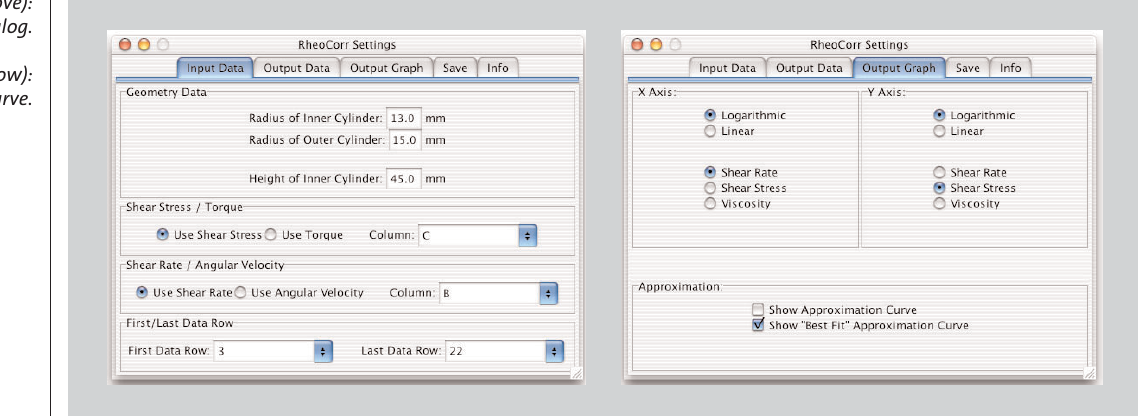
Figure 2 (above): Settings dialog. Figure 3 (below): Corrected flow